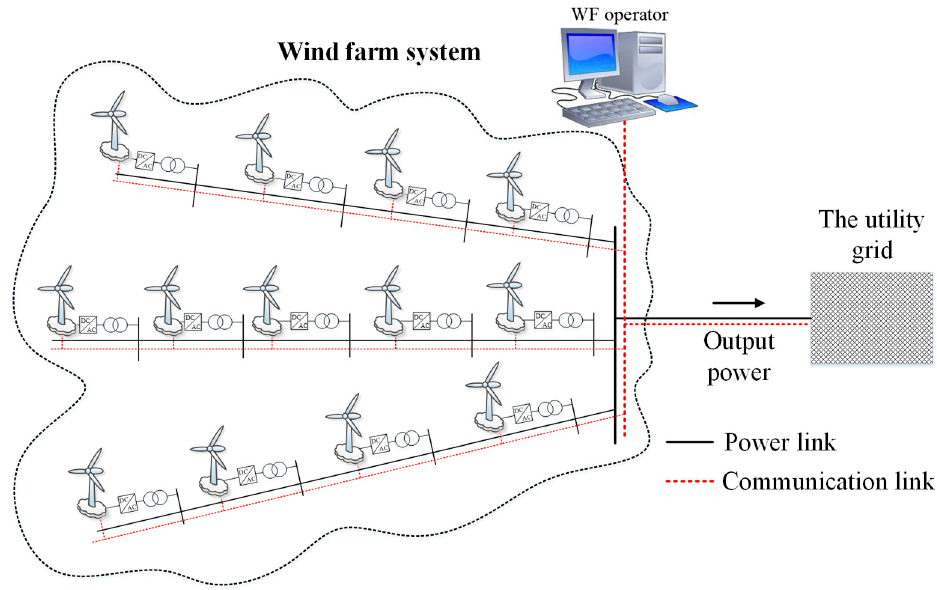
Figure 1. A typical WF system configuration.